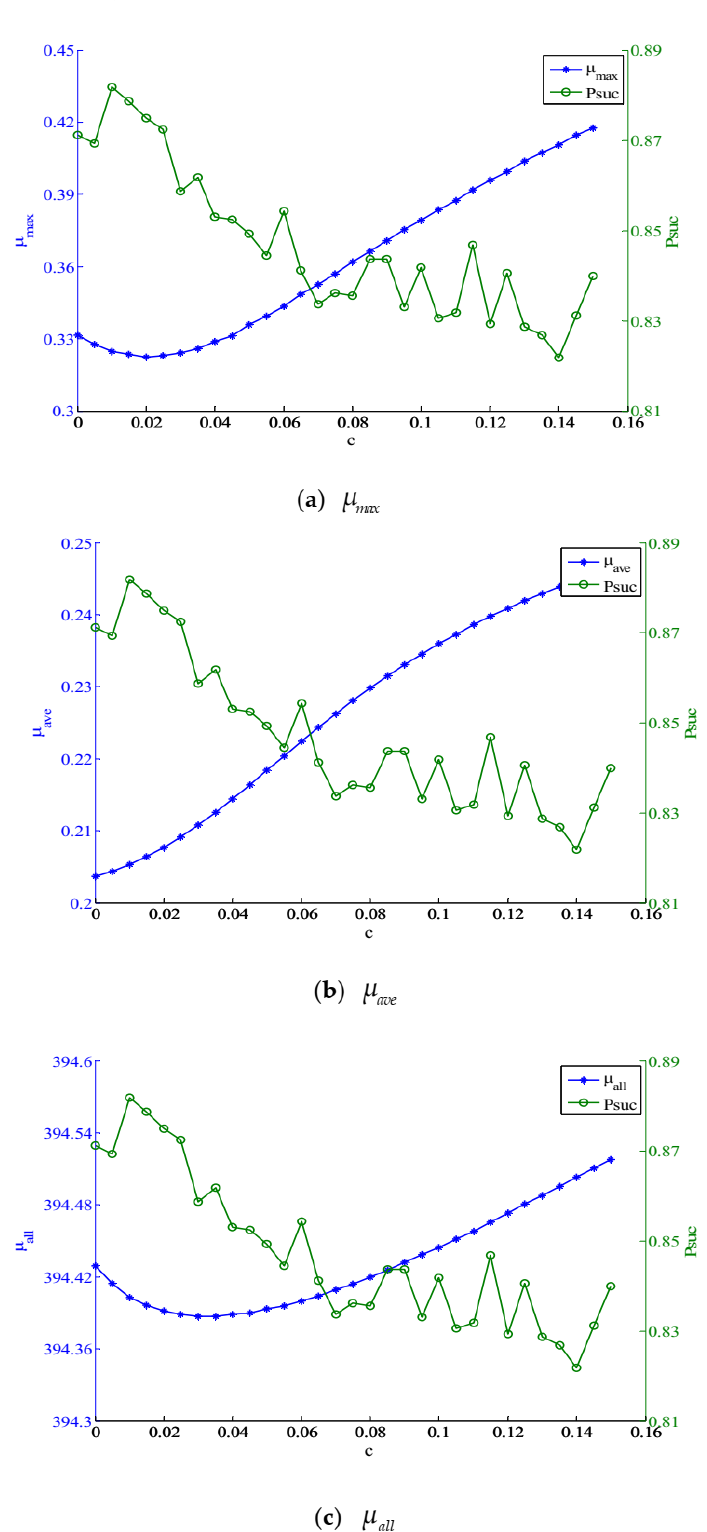
Figure 1. ( a ) µ max and P suc versus c ; ( b ) µ ave and P suc versus c ; ( c ) µ all and P suc versus c , both with M = 28 and K =